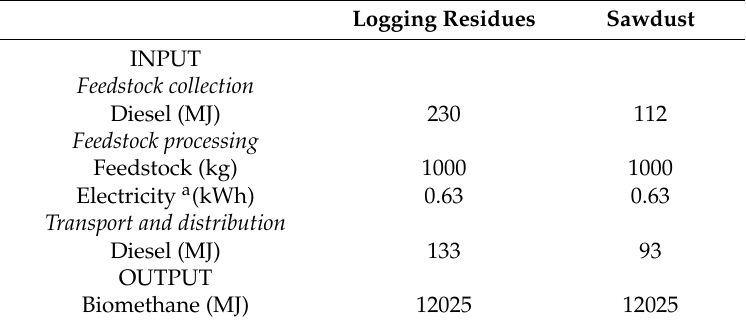
Table A3. Life cycle inventory of LBG production from 1000 kg feedstock [17,23,26].